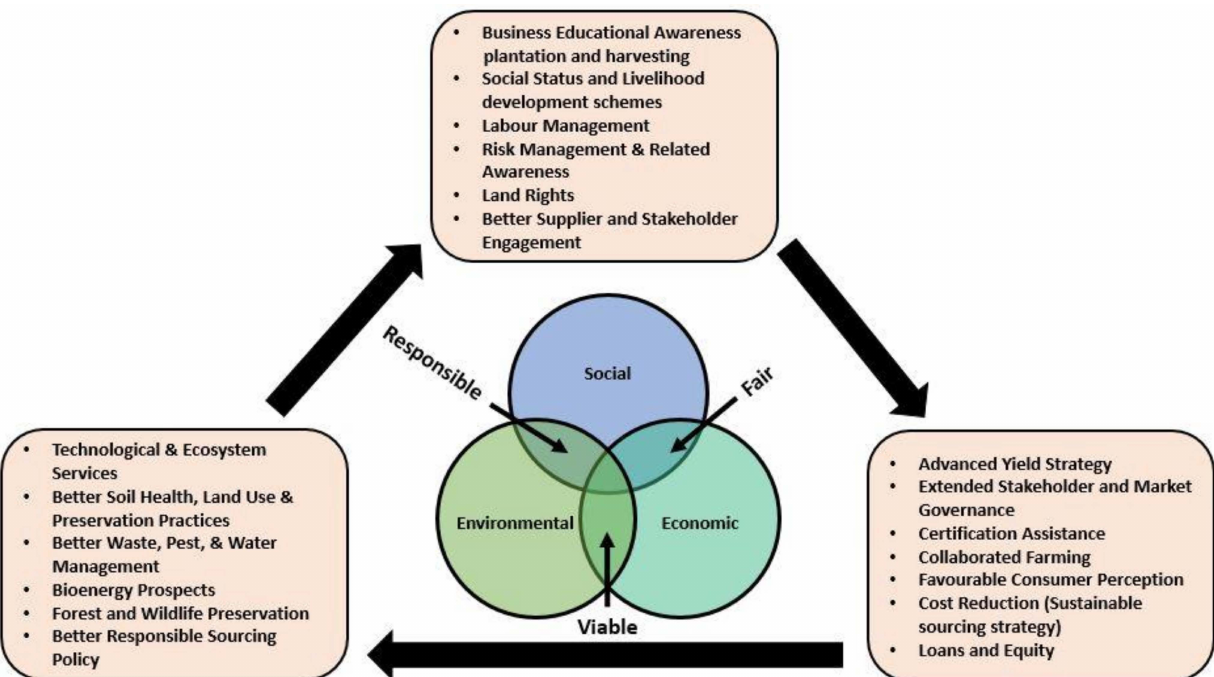
Figure 10. Conceptual framework (small holder sustainability in palm oil